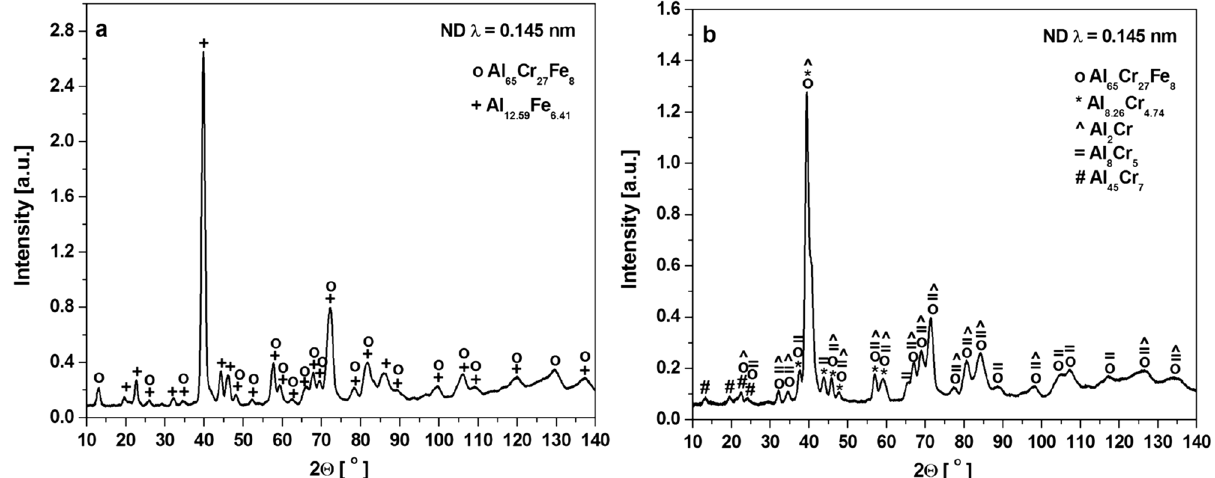
Figure 1. ND patterns of Al 65 Cr 20 Fe 15 ( a ) and Al 71 Cr 24 Fe 5 ( b ) alloys in a form of ingot.